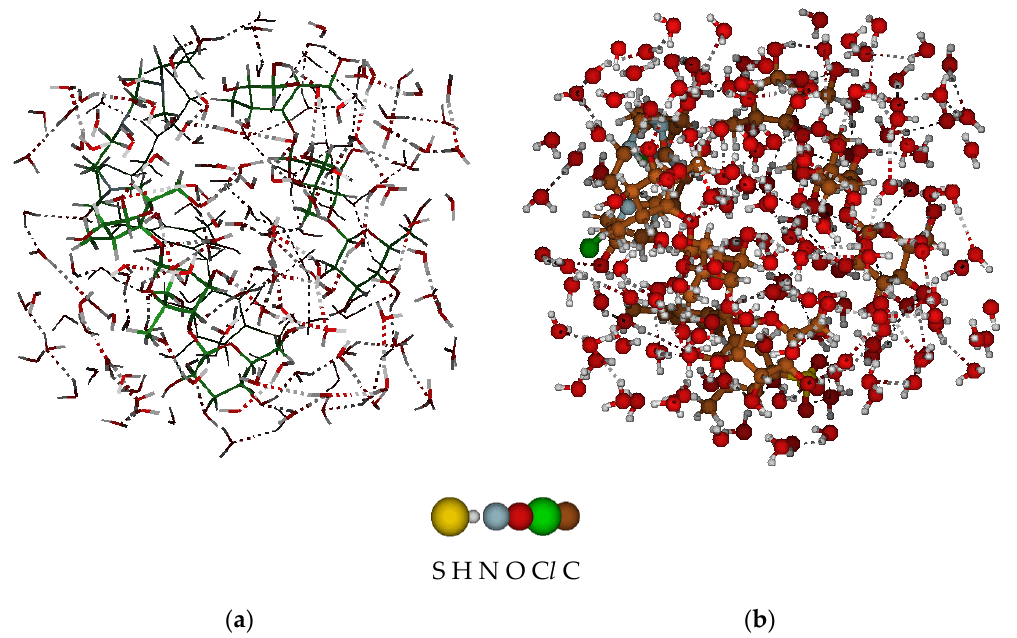
Figure 6. Membrane “Polykon AC” in a water cluster with formed hydrogen bonds (dotted lines). ( a ) A model of the behavior of the “Polikon AC” membrane in an aqueous solution. ( b ) The conformation of the molecular model.